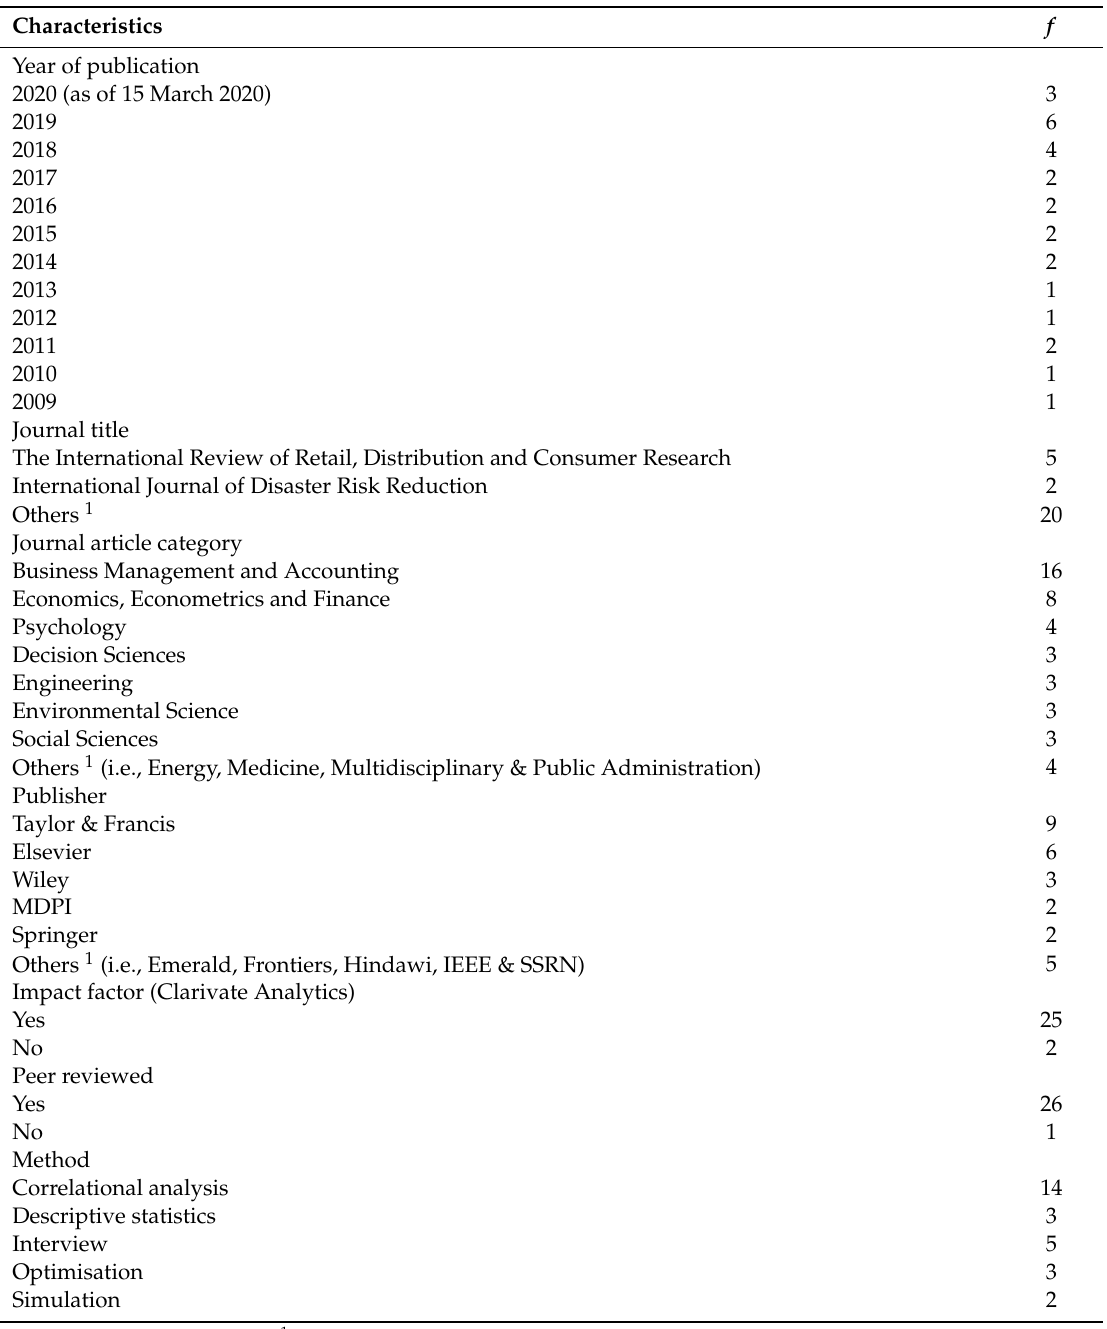
Table 2. Descriptive statistics ( n =